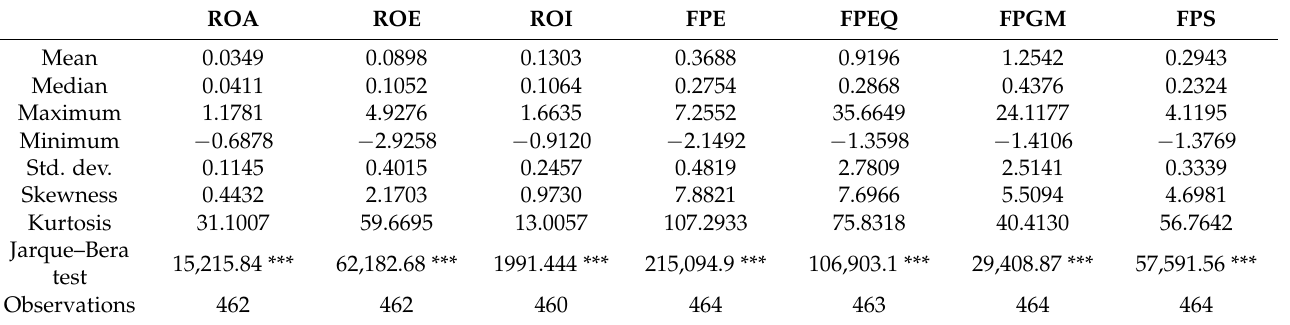
Table 1. Descriptive statistics for oil